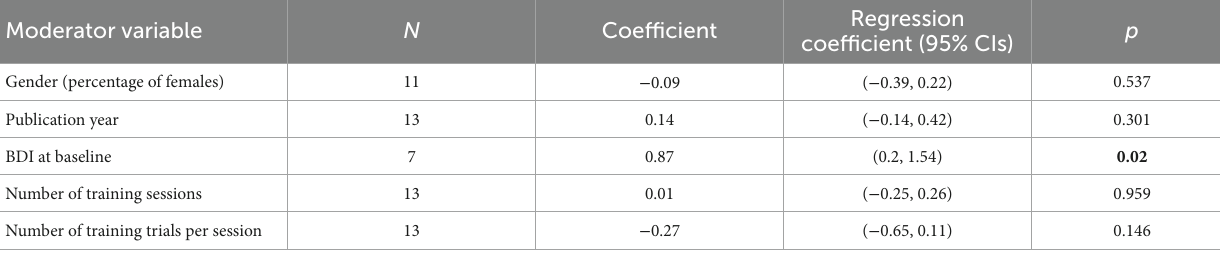
TABLE 3 Meta-regression of depression outcome in comparison with ABM versus